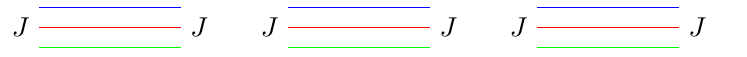
Figure 4 . An example of an empty graph, from a collection of disjoint empty trees that does not contain any interaction vertices but contribute to the leading order in the large N